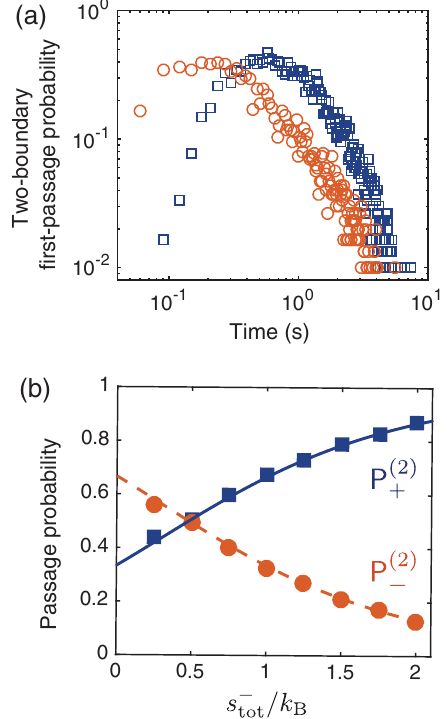
FIG. 9. First-passage statistics of entropy production with two 2 s − absorbing and asymmetric boundaries at values s þ for the tot tot ¼ Smoluchowski-Feynman ratchet with potential (79) in a steady state. (a) The first-passage-time distribution p ð t ; s þ tot Þ (blue T ð 2 Þ þ 2 k open squares) for entropy production to first reach s þ B tot ¼ − k given that it has not reached − s − before, and the first- B tot ¼ passage-time distribution p ð t ; − s − tot Þ (red open circles) to first T ð 2 Þ − reach − s − given that it has not reached s þ before. The data are tot tot from 10 4 simulations of the Smoluchowski-Feynman ratchet using the same simulation parameters as in Fig. 7. (b) Passage 2 Þ probabilities for entropy production P ð (blue filled squares) to þ first reach the positive threshold s þ given that it has not reached tot − s − before, and the passage probability for entropy production tot P ð 2 Þ − s − − (red filled circles) to first reach the positive threshold tot given that it has not reached s þ before. We show the passage tot probabilities as a function of the negative threshold value s − ; tot 2 s − the positive threshold is s þ . The curves represent the tot tot ¼ analytical expressions for the passage probabilities given by FIG. 10. Waiting-time statistics between the states X and X as I II 2 Þ illustrated in panel (a) for the Smoluchowski-Feynman ratchet Eqs. (5) and (6) ( P ð , blue solid curve; P ð 2 Þ − , red dashed curve). þ with the potential (79). In panel (b), simulation results are shown for the normalized waiting-time distributions of transitions I → II (blue squares) and of reversed transitions II → I (red circles). The simulations are done with the same parameters as in Fig. 7, and function of the value of the negative threshold s − . tot the distributions are obtained from 10 4 trajectories. Inset: Logarithm of the ratio between P I → II and P II → I − as a function þ of the environment-entropy change in the transition I → II (magenta diamonds). The transition probability P I → II ð P II → I − Þ is þ X the fraction of the trajectories starting from X at t ¼ 0 that I ð II Þ X X reach X at a later time t > 0 without returning to X II ð I Þ I ð II Þ before. The solid line is a straight line of slope 1. The data in the inset are obtained from 10 5 simulations starting from state I and 10 5 simulations starting from state